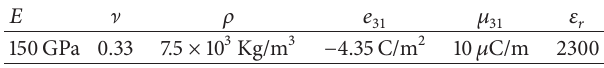
Table 1: Material constants of the piezoelectric microbeam [8–11]. 𝐸 ] 𝜌 𝑒 150 GPa